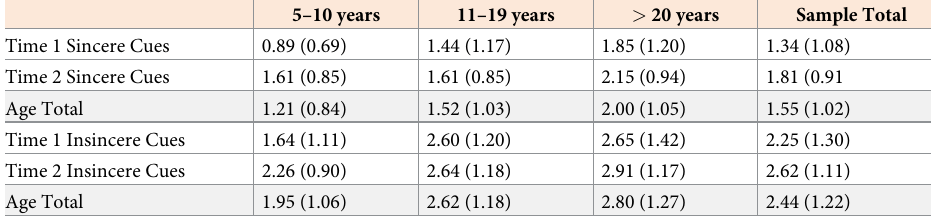
Table 3. Mean (SD) proportion scores of sincere/benign and insincere/hostile cues in social perception vignettes across age